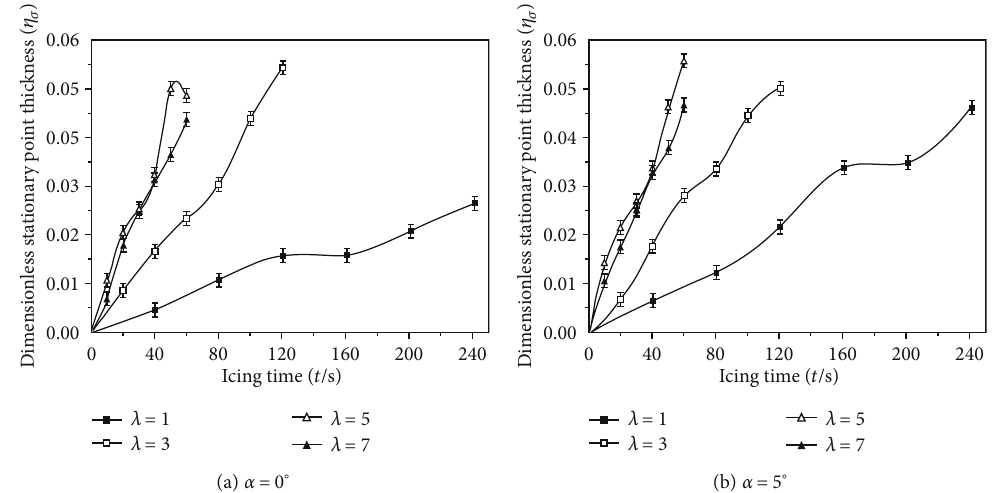
Figure 23: Dimensionless stationary point thicknesses under di ff erent tip speed ratios.